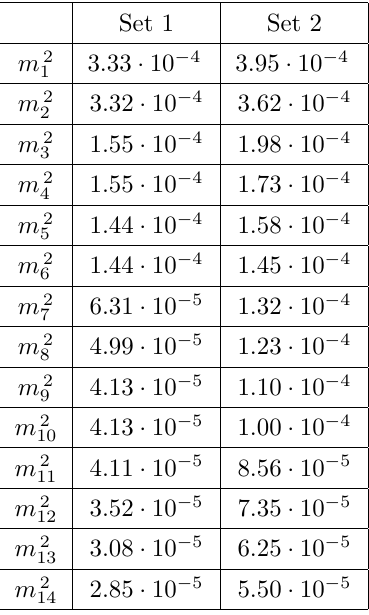
Table 7 . The canonically normalized masses in the de Sitter vacuum for the seven-moduli case. moduli in a supersymmetric anti-de Sitter minimum with all six mass eigenvalues positive. Thus, with the standard K(cid:127)ahler potential for the STU model in equation (2.6) and with the simple